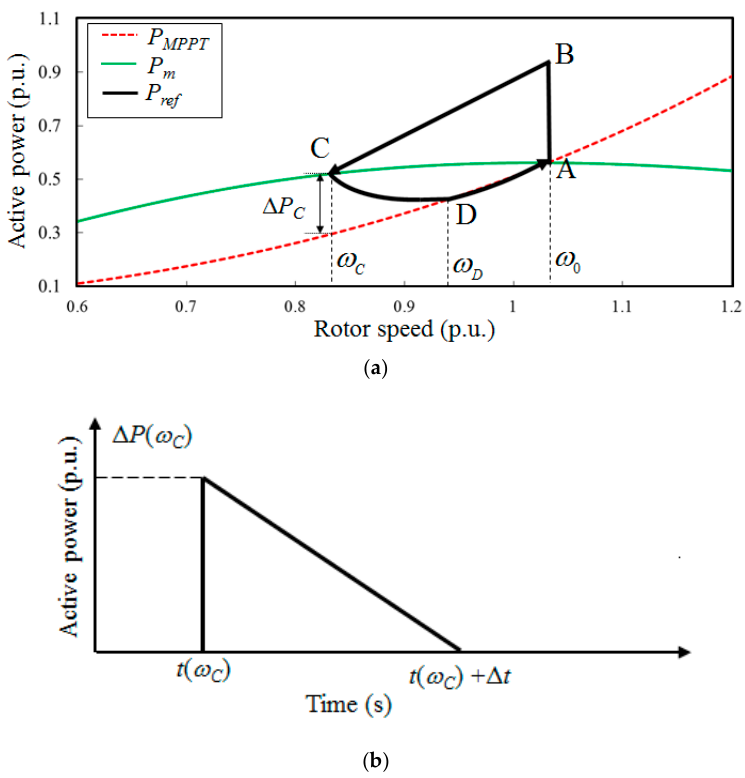
Figure 4. Power-rotor speed trajectory of the proposed method: ( a ) power-rotor speed trajectory of the proposed method; ( b ) Δ p ( ω C ).